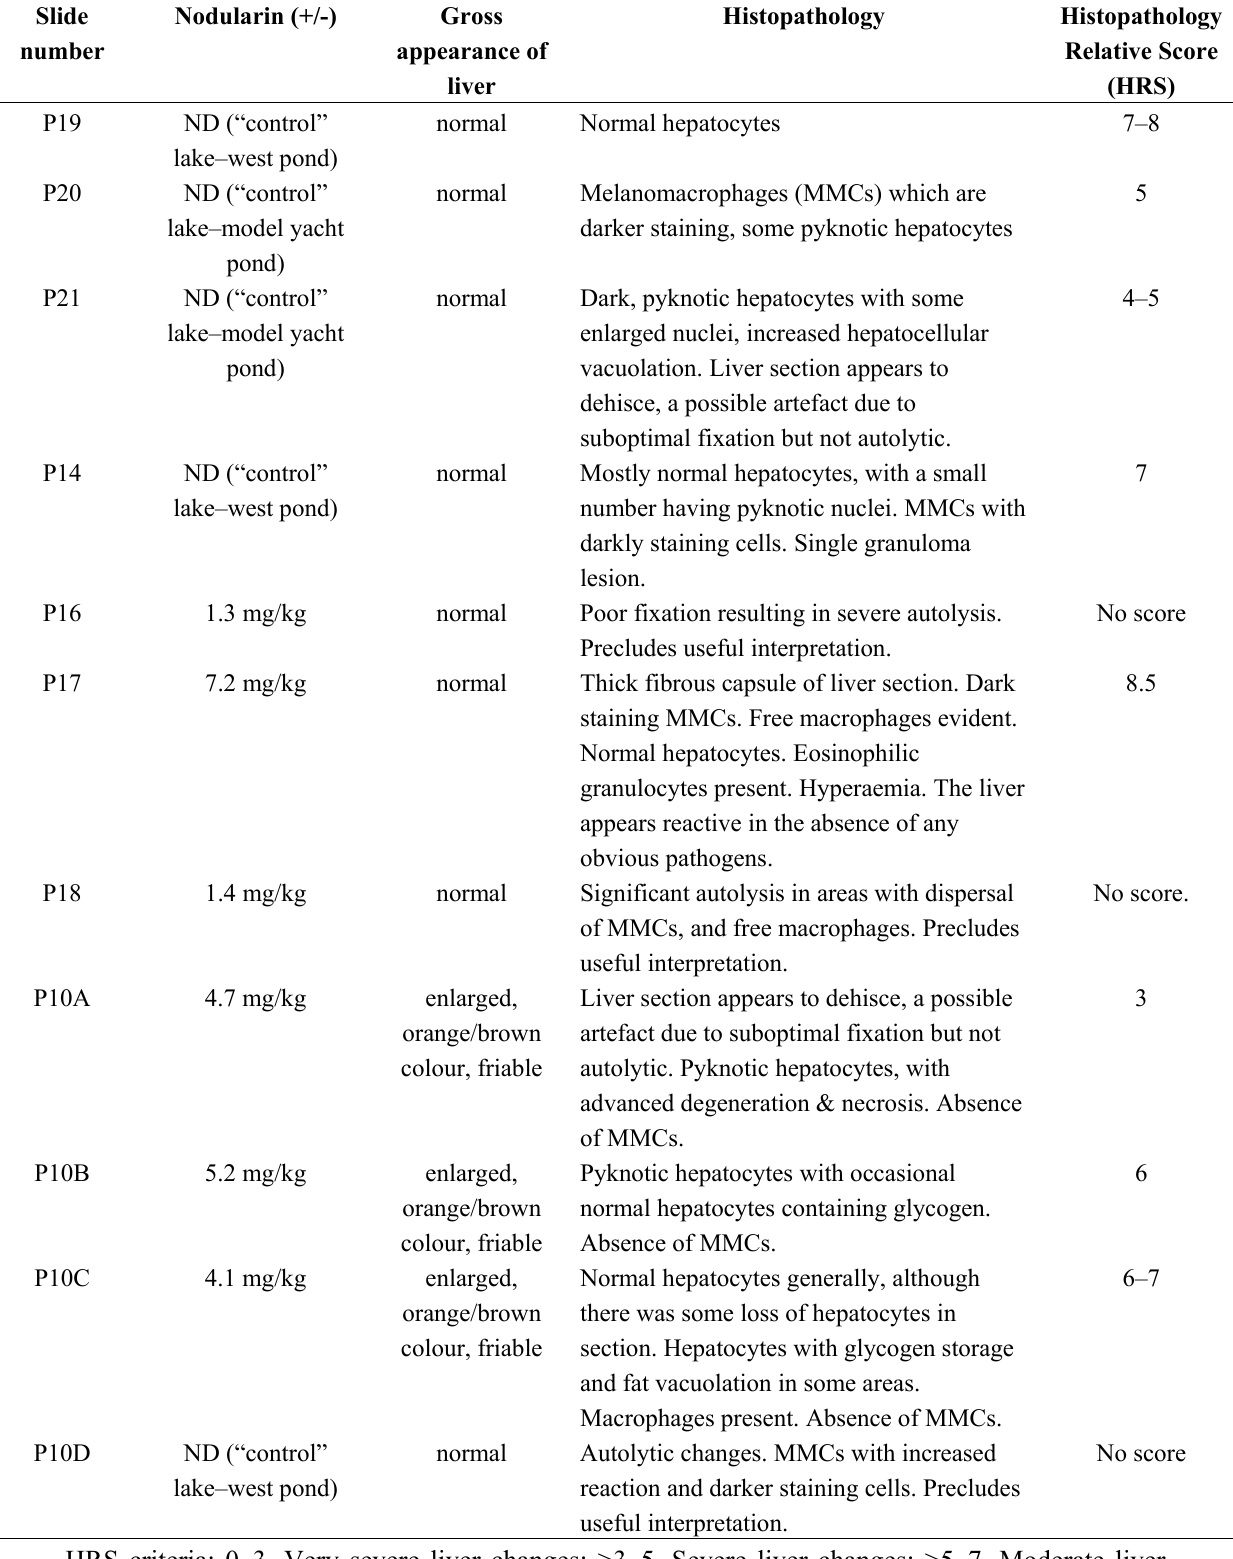
Table 5. Blinded histopathology examination of livers from the study lake and nearby “control” lakes. Fish captured on two occasions in September